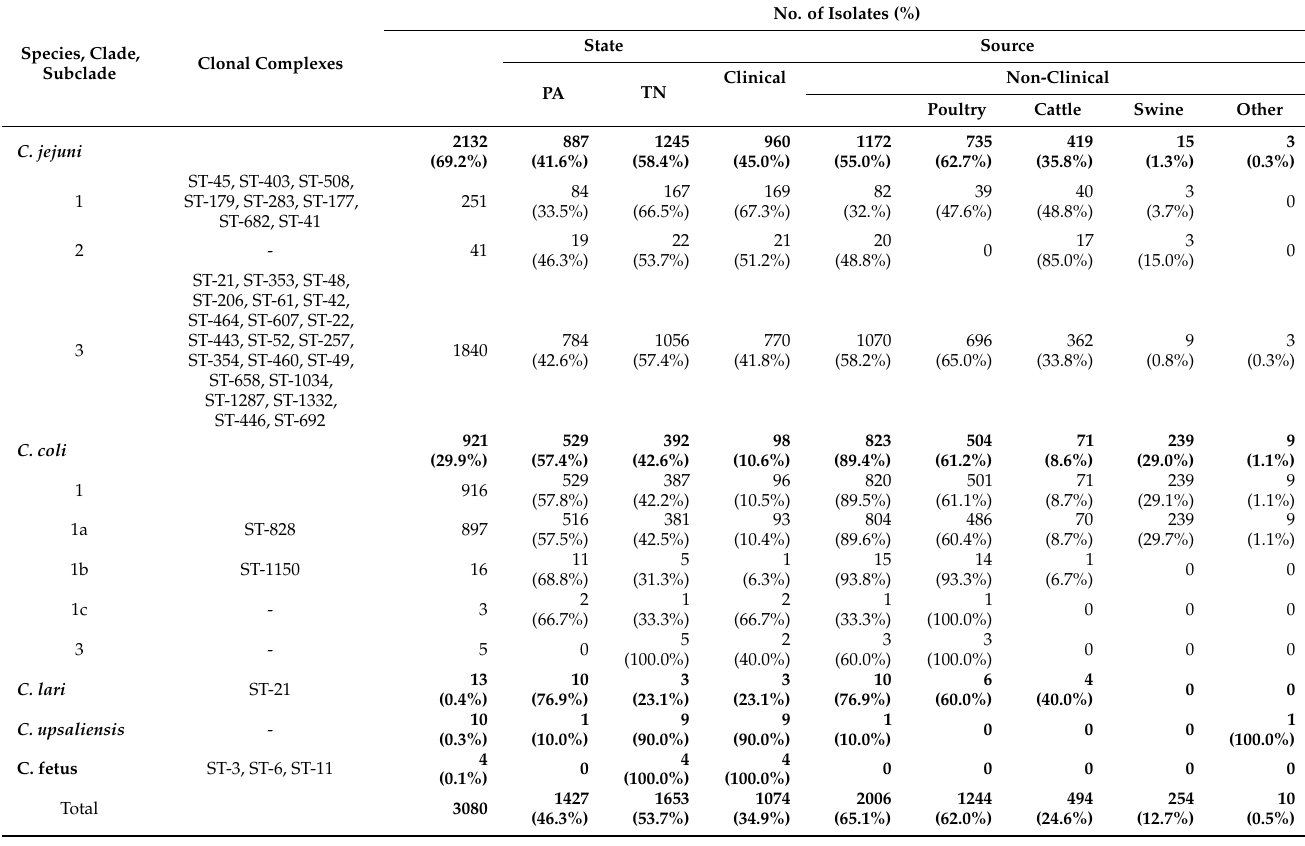
Table 1. Summary of isolates used in the present study and statistics by species and clade.